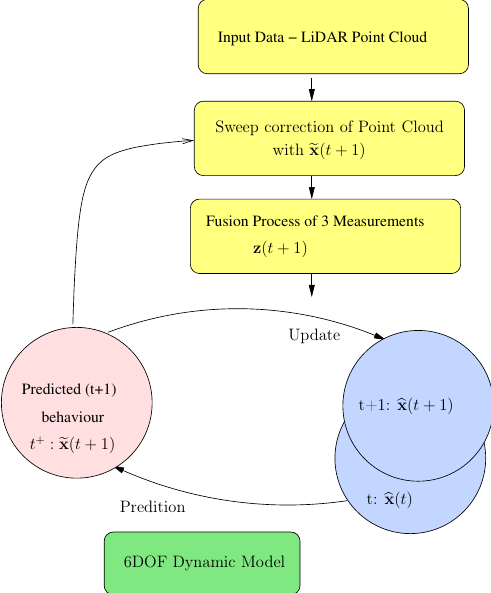
Figure 6. Unscented Kalman Filter (UKF) architecture. The prediction phase relies on the 6-DoF motion model detailed in the previous section. The update phase uses three consecutive LiDAR-based measurements to fuse and estimate the vehicle